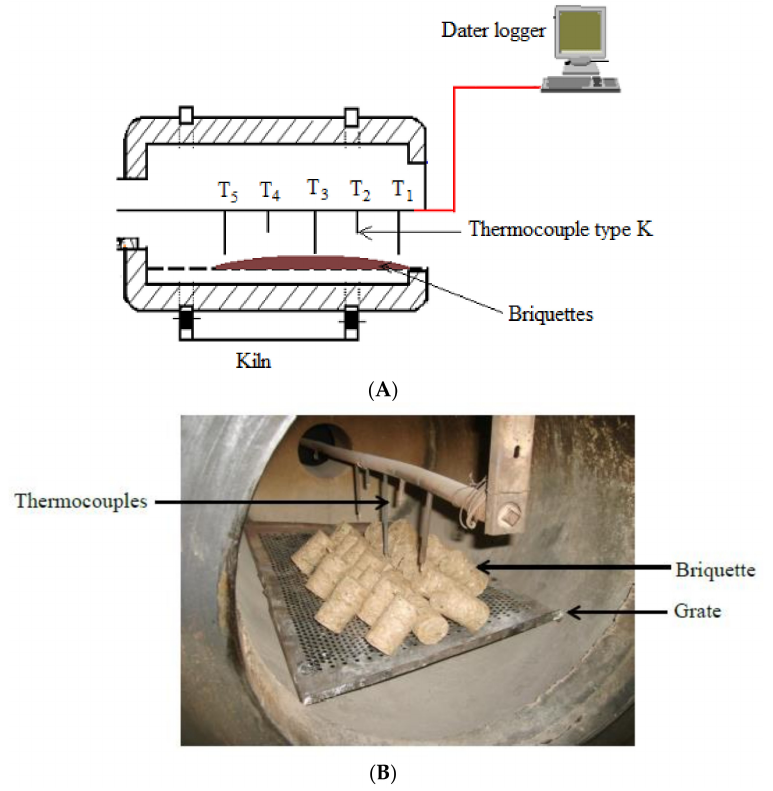
Figure 1. Experimental device of the briquettes combustion. ( A ) Schematic Diagram of the device; ( B ) Arrangement of briquettes in the rotary